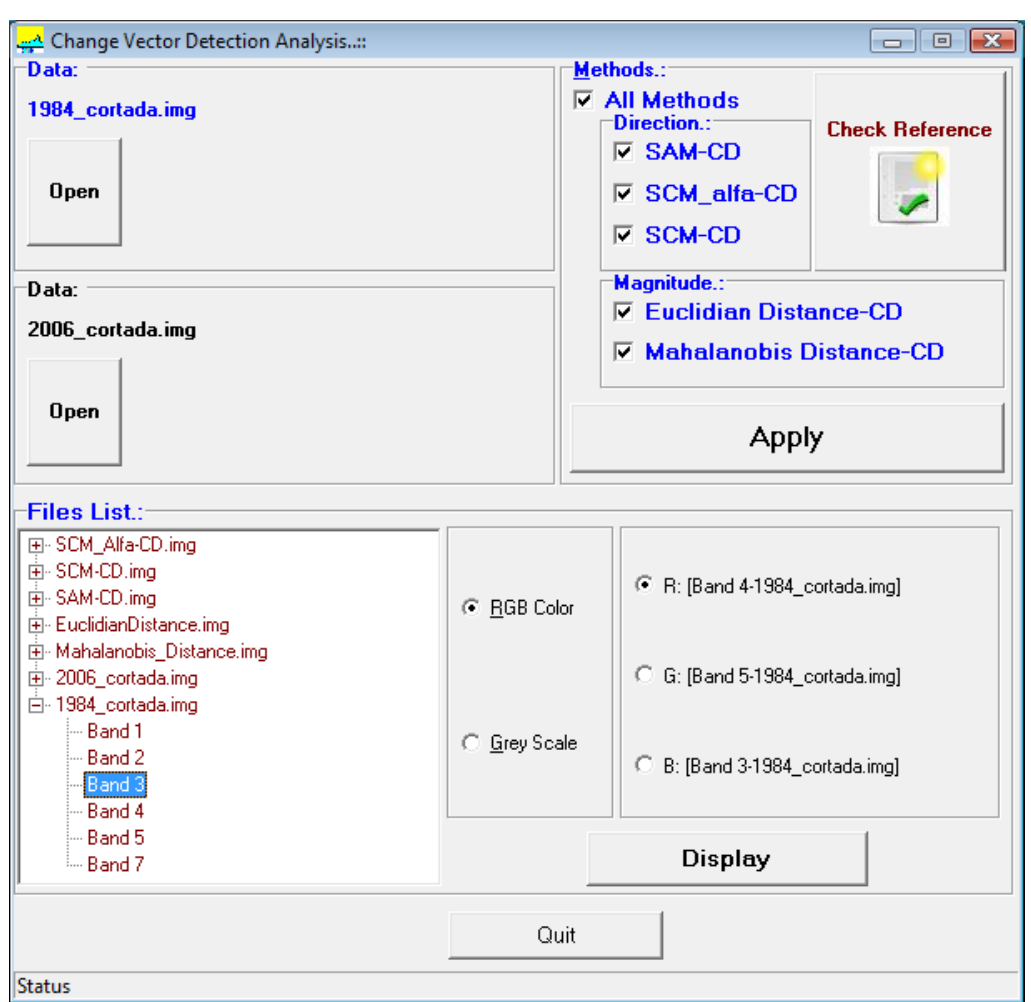
Figure 12. Main window interface contains image input boxes, CVA method functions and image